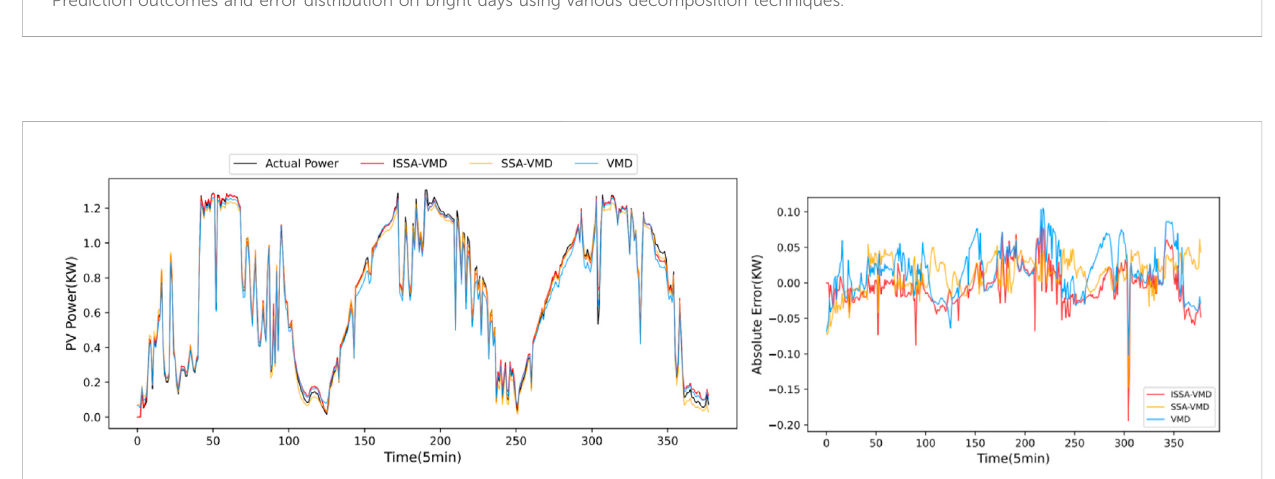
FIGURE 12 Prediction outcomes and error distribution on bright days using various decomposition techniques.